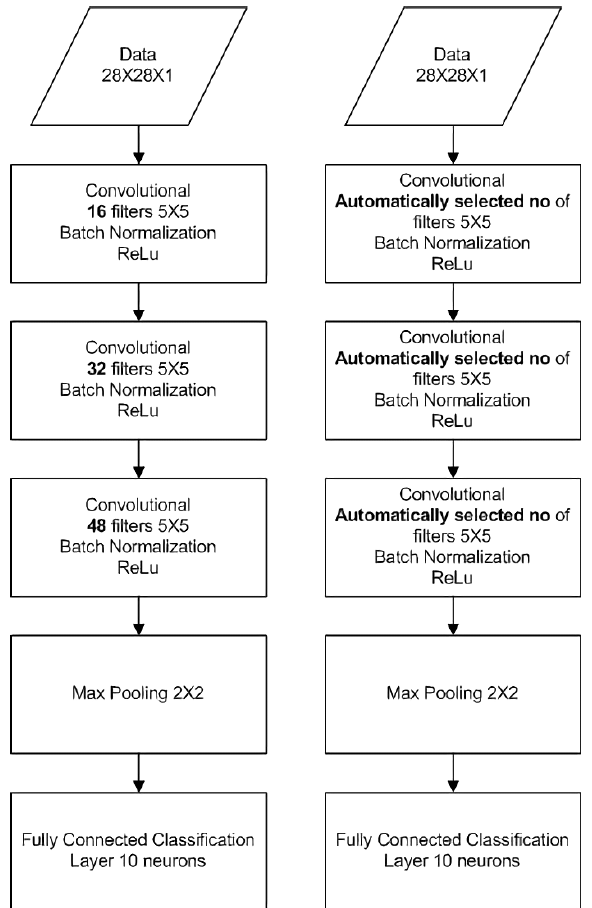
Figure 10. Vanilla CNN for MNIST classification ( left ), Adaptive CNN for MNIST classifica- tion ( right ).